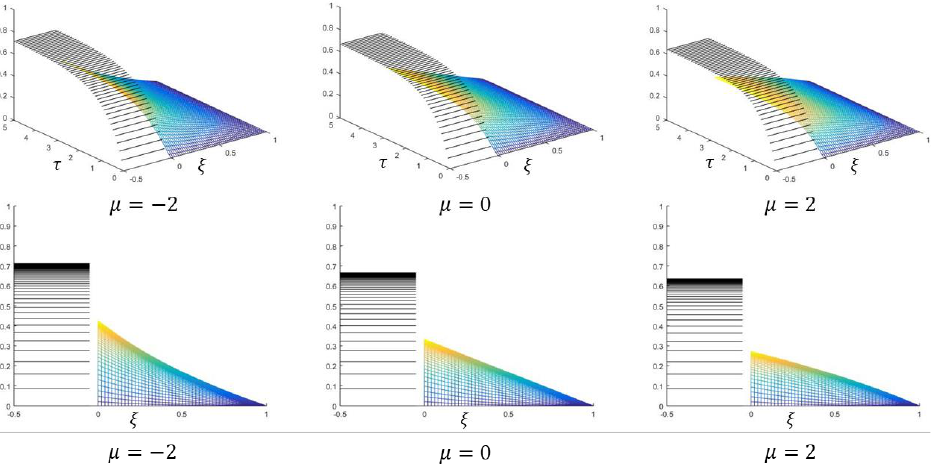
Figure 3. In the top row, the temperature in the tank 𝜓(𝜏) (black) and the temperature in the solid body θ ( ξ , τ ) (color) for g ( θ ) = e µθ , µ = − 2,0,2 are shown. In the bottom row, the corresponding side body 𝜃(𝜉, 𝜏) (color) for 𝑔(𝜃) = 𝑒 𝜇𝜃 , 𝜇 = −2, 0,2 are shown. In the bottom row, the corresponding side views are shown, i.e., the temperature profiles at times 𝜏 = 0.1, 0.2,… , 5.0 . views are shown, i.e., the temperature profiles at times τ = 0.1,0.2, . . . ,5.0.